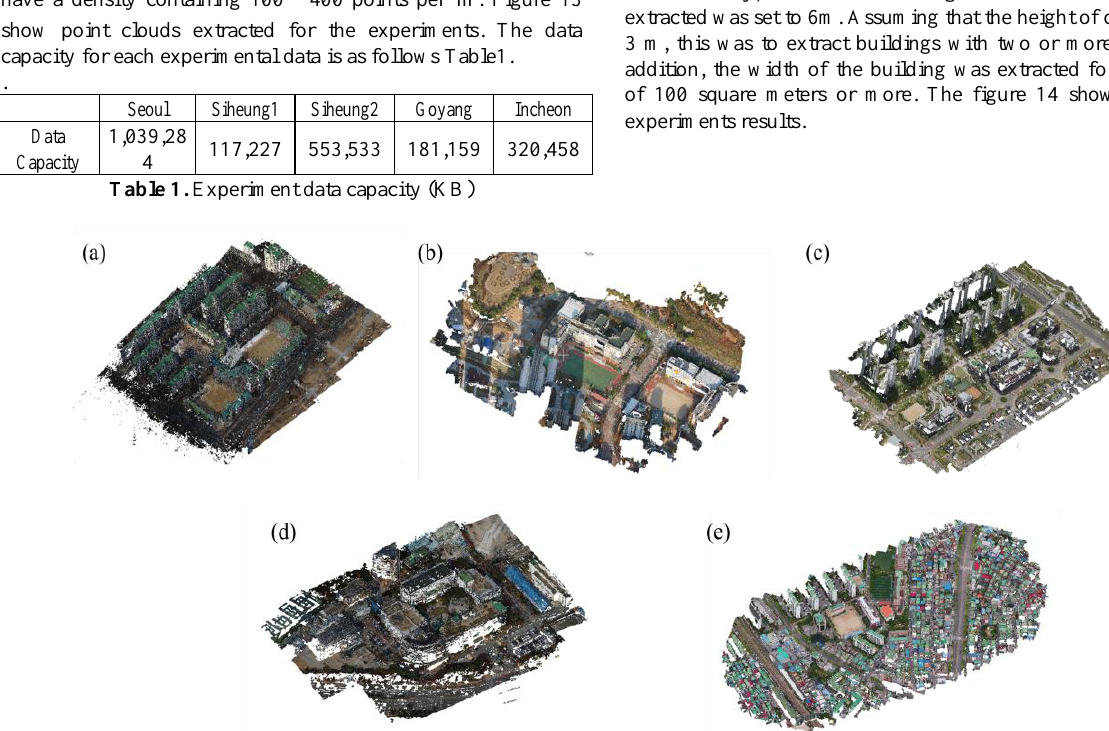
Figure 13. Experiments data. (a)Seoul, (b)Siheung1, (c)Siheung2, (d)Goyang,